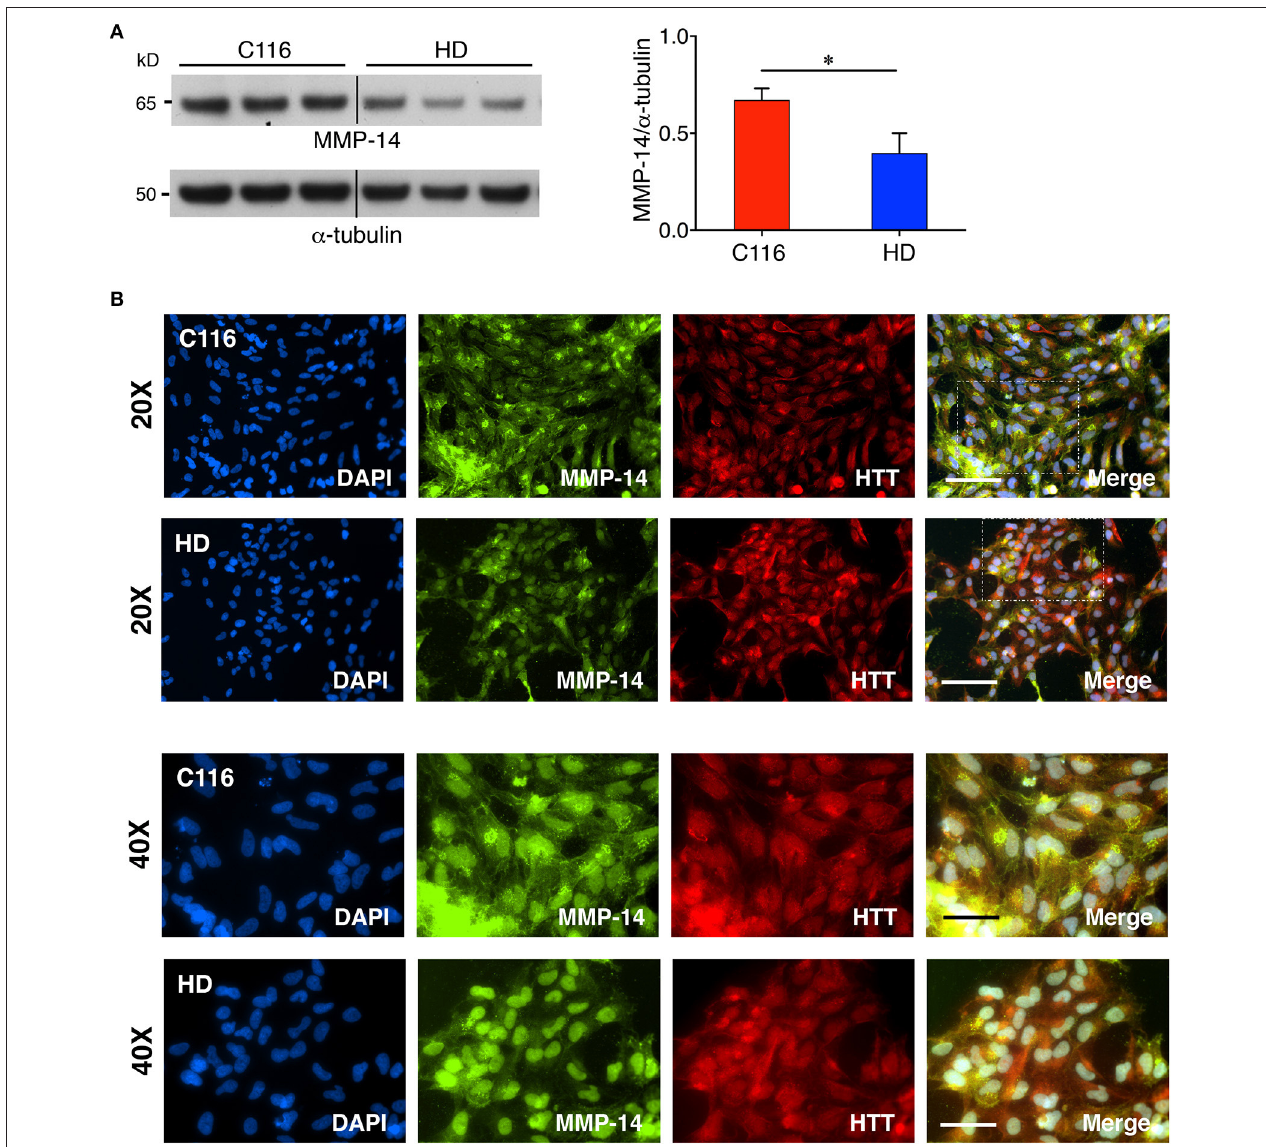
FIGURE 3 | Decreased MMP-14 expression in HD-NSCs. (A) Western blot analysis of MMP-14 shows a significantly decreased expression of MMP-14 in HD-NSCs. MMP-14 immunoreactivity was quantified by densitometry and normalized for α -tubulin immunoreactivity ( n = 3 BR, * p < 0.05; t -test). Error bars represent SD . (B) Immunofluorescence analysis of MMP-14 not only confirms decreased expression in HD vs. C116-NSCs, but also reveals predominantly nuclear expression of MMP-14 in HD-NSCs which possibly associates with nuclear mHTT expression (40X magnified insets). Scale Bars: 20X = 100 µ m, 40X = 50 µ